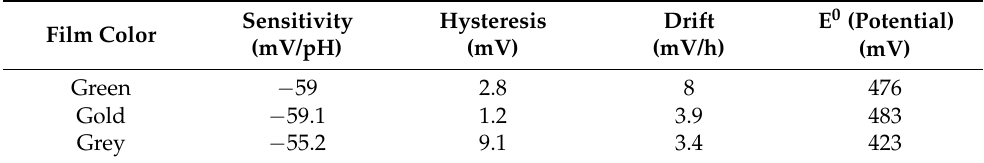
Color Chromaticity Properties of As-Deposited TiN Films The color chromaticity properties of as-deposited TiN thin films were characterized using a Konica Minolta 508D colorimeter. The chromaticity values of the gold TiN thin film were characterized based on the Hunter L , a , b color scale. The explanation of the Hunter Lab color space is presented in references [31,32]. The L value represents the black and white color depending on the values (0–100), and a and b values represent red to green and yellow to blue, respectively. Table 3 reports the correlation between the film color and the process parameters. Table 3. Sputtering parameters for Titanium Nitride different colored thin film